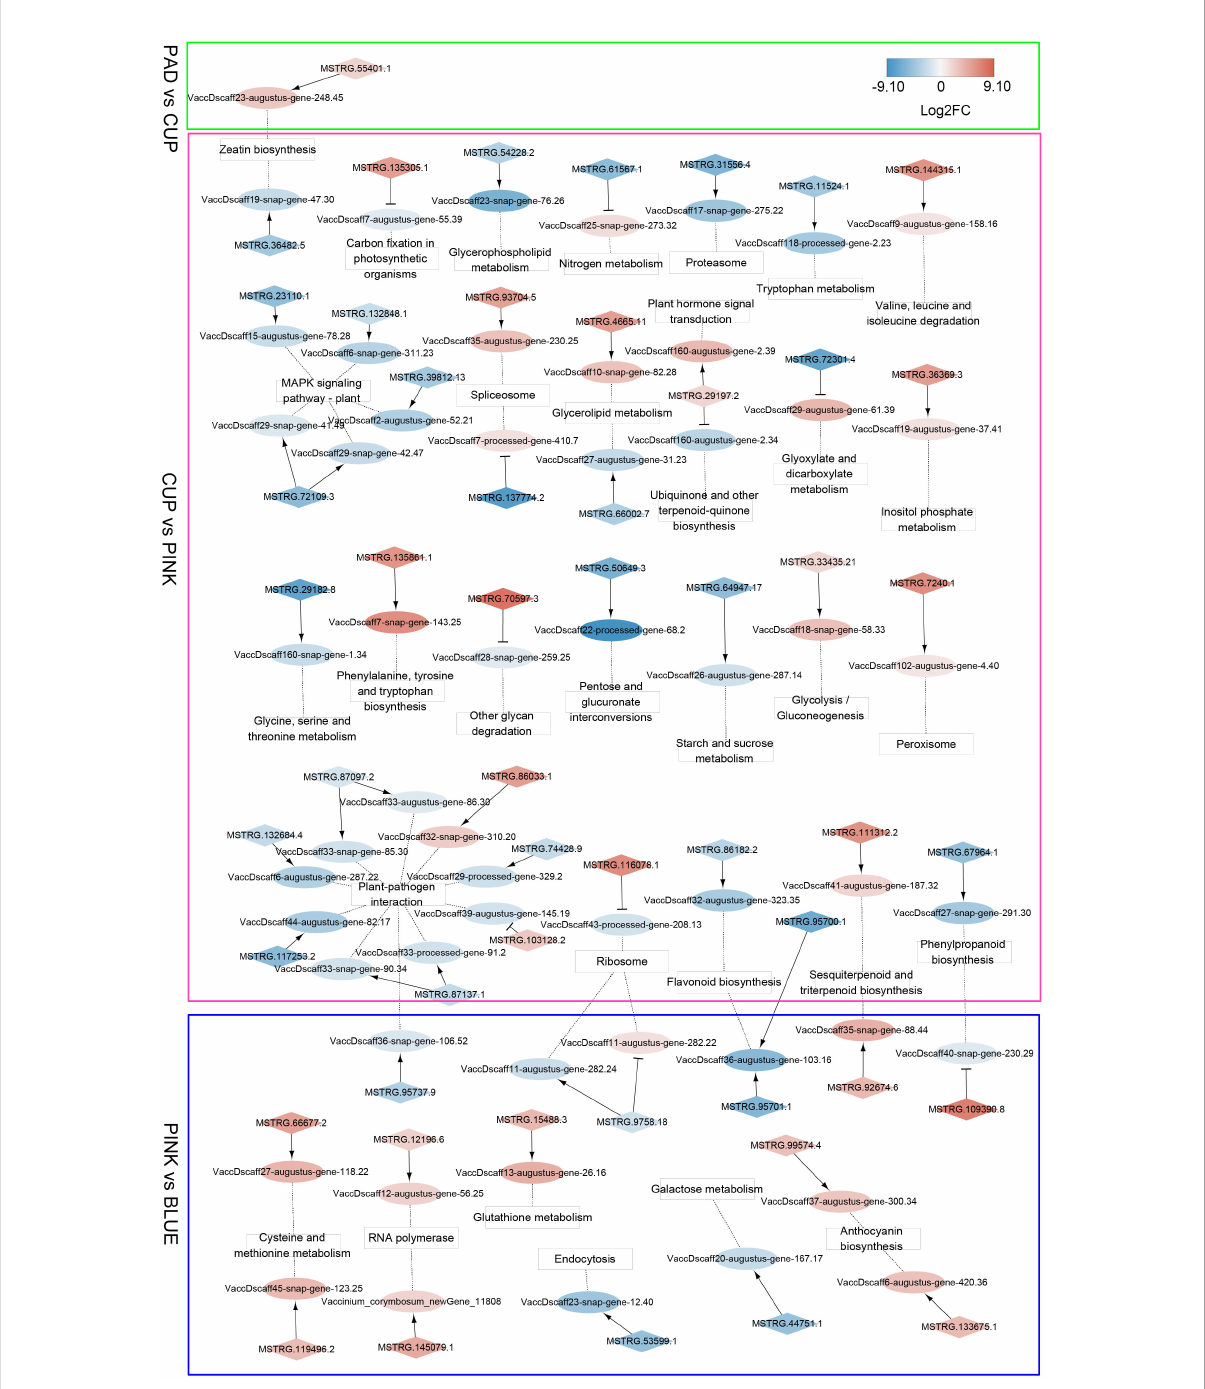
FIGURE 6 Co-localization networks of differentially expressed lncRNAs (DE-lncRNAs) and their adjacent genes enriched by Kyoto Encyclopedia of Genes and Genomes (KEGG) annotation. LncRNAs and protein-coding genes are indicated by diamonds and ellipses, respectively. KEGG terms are shown in square frames. The fold changes of transcripts are indicated by differential colors, with red and blue indicating upregulated and downregulated transcripts, respectively. Arrows indicate positive co-expression between lncRNAs and their target genes, and T-shaped lines indicate negative co-expression. Dotted lines connect the target genes and their KEGG